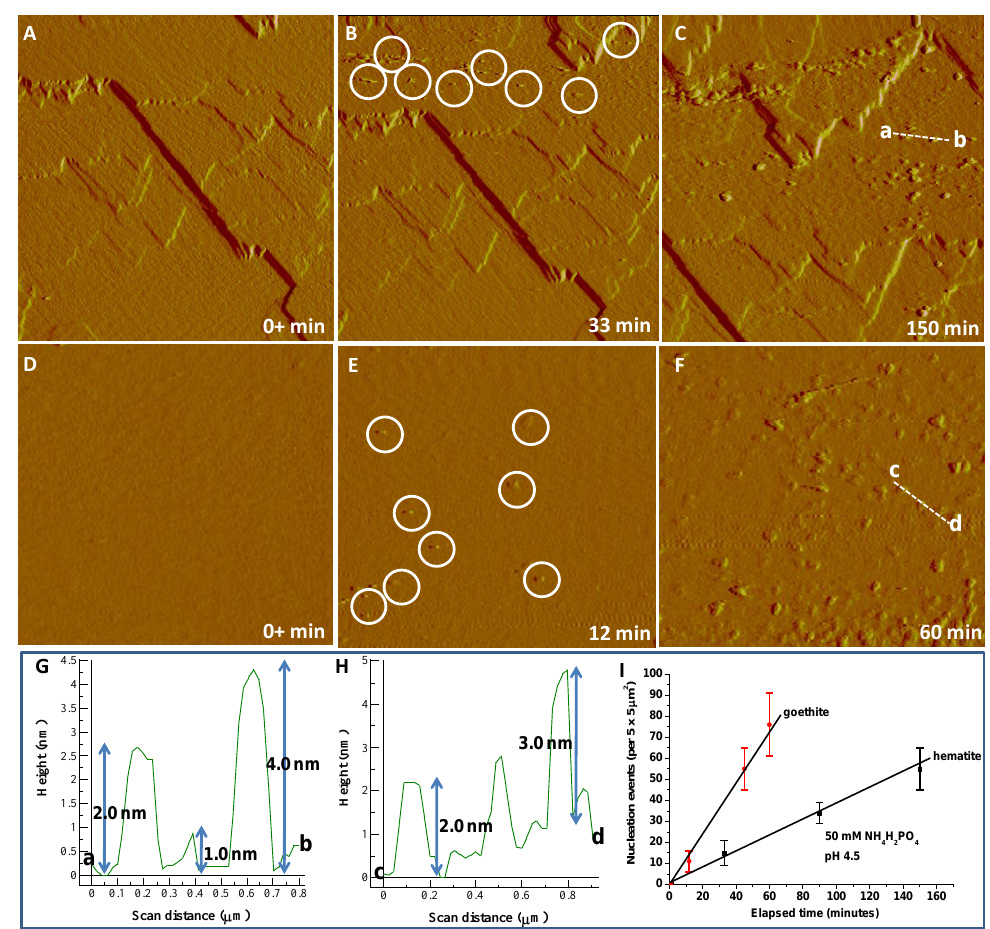
Figure 1. AFM time sequence (deflection images) showing in situ nucleation kinetics of Fe-P phases and the growth evolution of precipitates on dissolving ( A – C ) hematite and ( D – F ) goethite surfaces in 50 mM NH 4 H 2 PO 4 (pH 4.5). Images ( A – F ), 5 μm × 5 μm. Height profile of the initially formed Fe-P nanoparticles (circled for clarity in ( B or E )) on a ( G ) hematite along section a → b (dashed line in ( C )) or ( H ) goethite face along section c → d (dashed line in ( F )). The average height of Fe-P nanoparticles is about 1.0–4.0 nm, and was almost unchanged in a short period (150 min) of reaction time. ( I ) Kinetic analysis of surface nucleation of Fe-P phases on hematite and goethite substrates in short periods of reaction times in 50 mM NH 4 H 2 PO 4 at pH 4.5, showing linear scaling of surface nucleation with time and dependence of the nucleation rate given by slopes of the lines (the solid line is a linear fit to the AFM data (the number of nucleated particles in a short time period)). Vertical error bars (the standard deviation of the mean) correspond to the variation in measured number of nucleated particles in three different areas in each experiment.